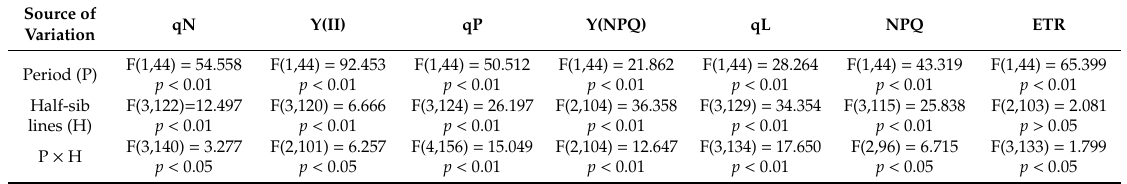
Table 5. Results of a two-way ANOVA in which the e ff ect of Period, Half-sib lines, and their interaction (Period × Half-sib line) on the observed chlorophyll a fluorescence parameters are